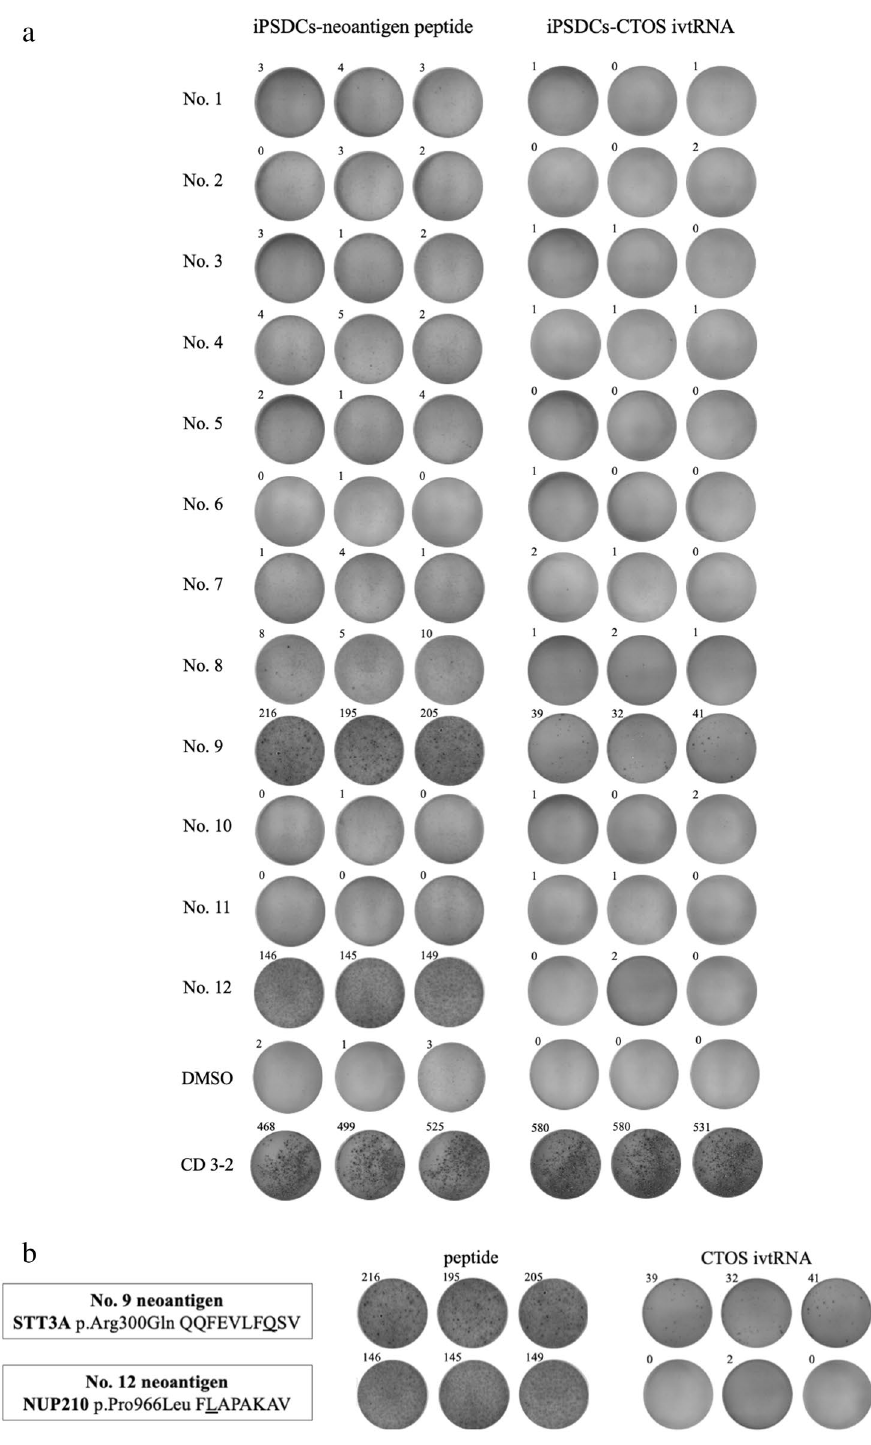
Figure 5. ELISpot assay of iPSDCs-neoantigen peptide and iPSDCs-CTOS ivtRNA. ( a ) IFN-γ secretion by CTLs induced by iPSDCs-neoantigen peptide and iPSDCs-CTOS ivtRNA against autologous dendritic cells co-cultured with neoantigen peptide. ELISpot experiments were performed in triplicate wells per condition. ( b ) Results of #9 and #12 candidate neoantigen peptide. The CTLs induced by iPSDCs-CTOS ivtRNA responded to #9 candidate neoantigen. Meanwhile, CTLs induced by iPSDCs-neoantigen peptide responded to #9 and #12 candidate neoantigens. The experiment was repeated twice with three wells, and the results were the